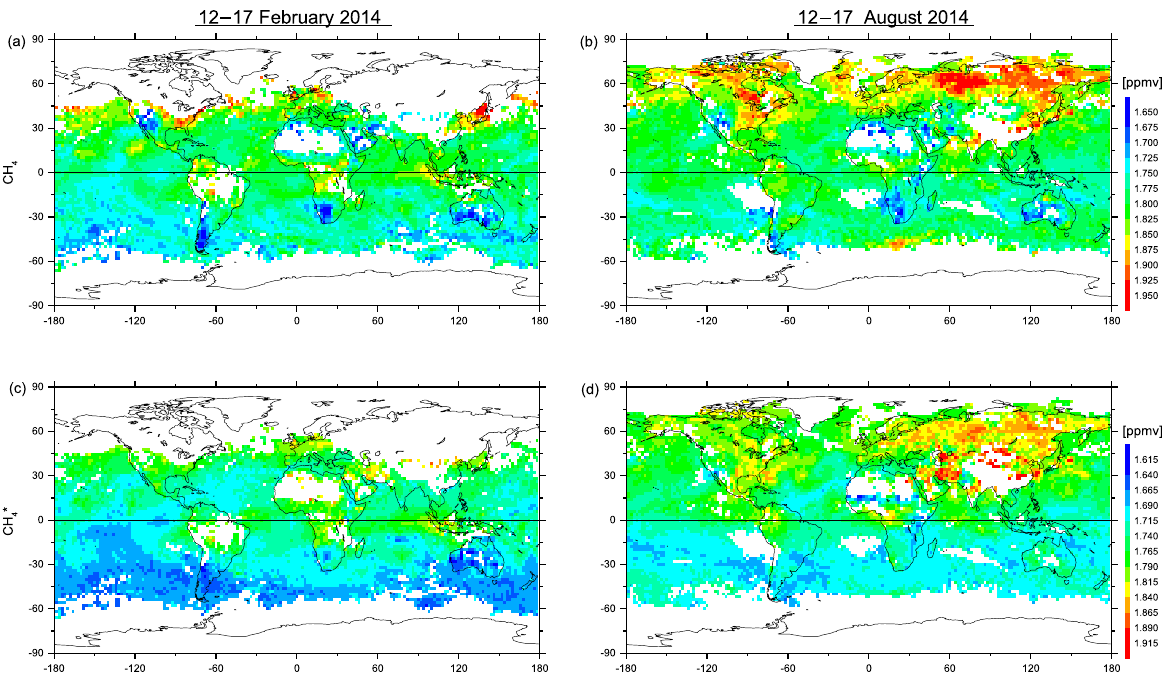
Figure B1. Free-tropospheric MUSICA IASI product retrieved at 4.2km altitude, filtered for c sen < 0 . 5 (according to Sect. 3.2) and averaged for an latitude × longitude area of 2 ◦ × 2 ◦ . (a) and (b) for CH 4 ; (c) and (d) for CH ∗ and c ) and mid-August 2014 ( b and d ).